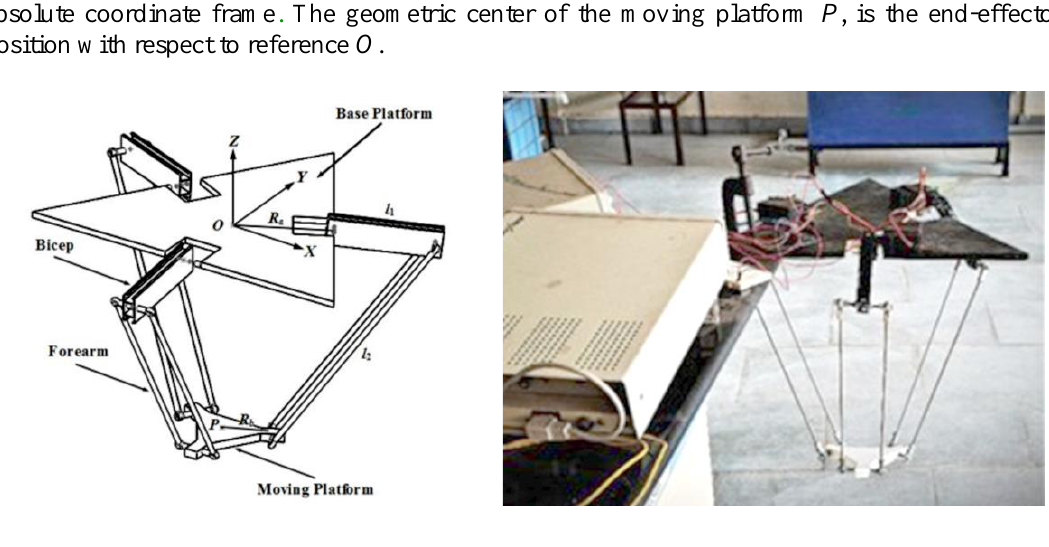
Figure 1. Description of D-PM. Figure 2. Developed model of D-PM.